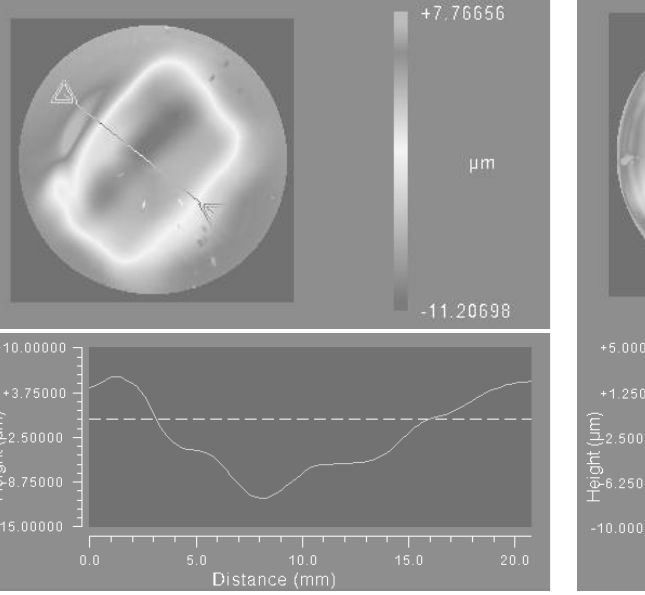
Fig. 1. New tool on SF57 Fig. 2. Slightly worn tool on SF57